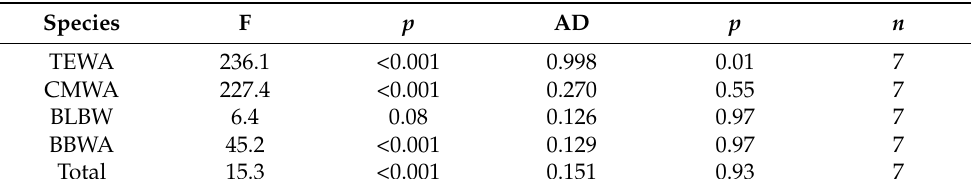
Table 4. ANOVA and Anderson-Darling residual normality tests of bird population density census (cid:113) data, pairs/km 2 . Significant F test triggered Bonferroni pairwise means comparisons in Figure 6a, separate for each bird species.